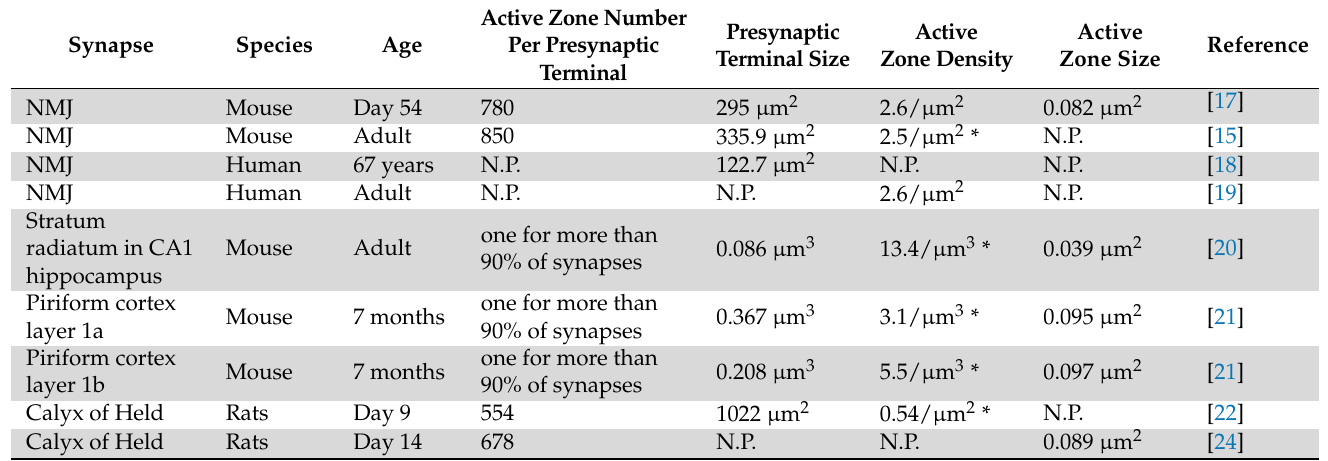
Table 1. Structural features of active zones at the presynaptic terminal.